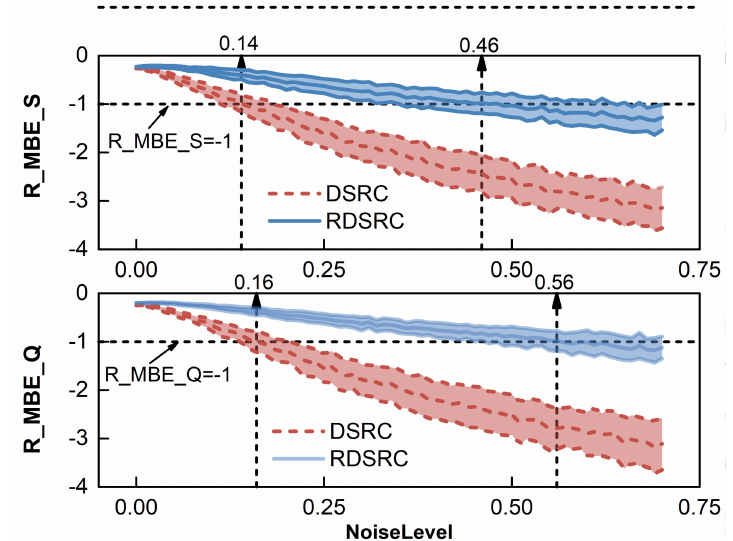
Figure 6. Plots of 71 sets of R_MBE for the free water storage and the discharge. The labels “R_MBE_S” and “R_MBE_Q” represent the results of the free water storage and the discharge, respectively. The straight line in the middle represents the mean values of 100 flood events (per level), and half the width of the filled area represents the corresponding standard